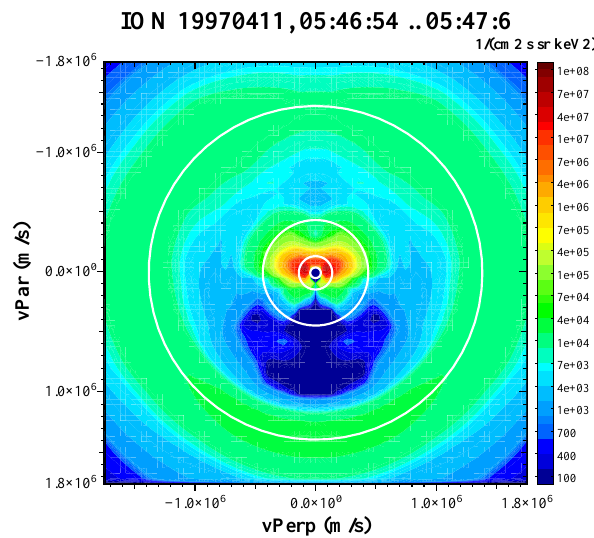
Fig. 4. Example of an event containing a half-consumed shell dis- tribution (i.e. downgoing part is intact but upgoing part has been flattened out). One-count level is 300 times smaller than the shell distribution level, MLT 24, ILAT 68.5, R = 4 . 6 R E , n = 1cm − 3 , T = 3 . 4keV, free energy density 0.44cm − 3 .